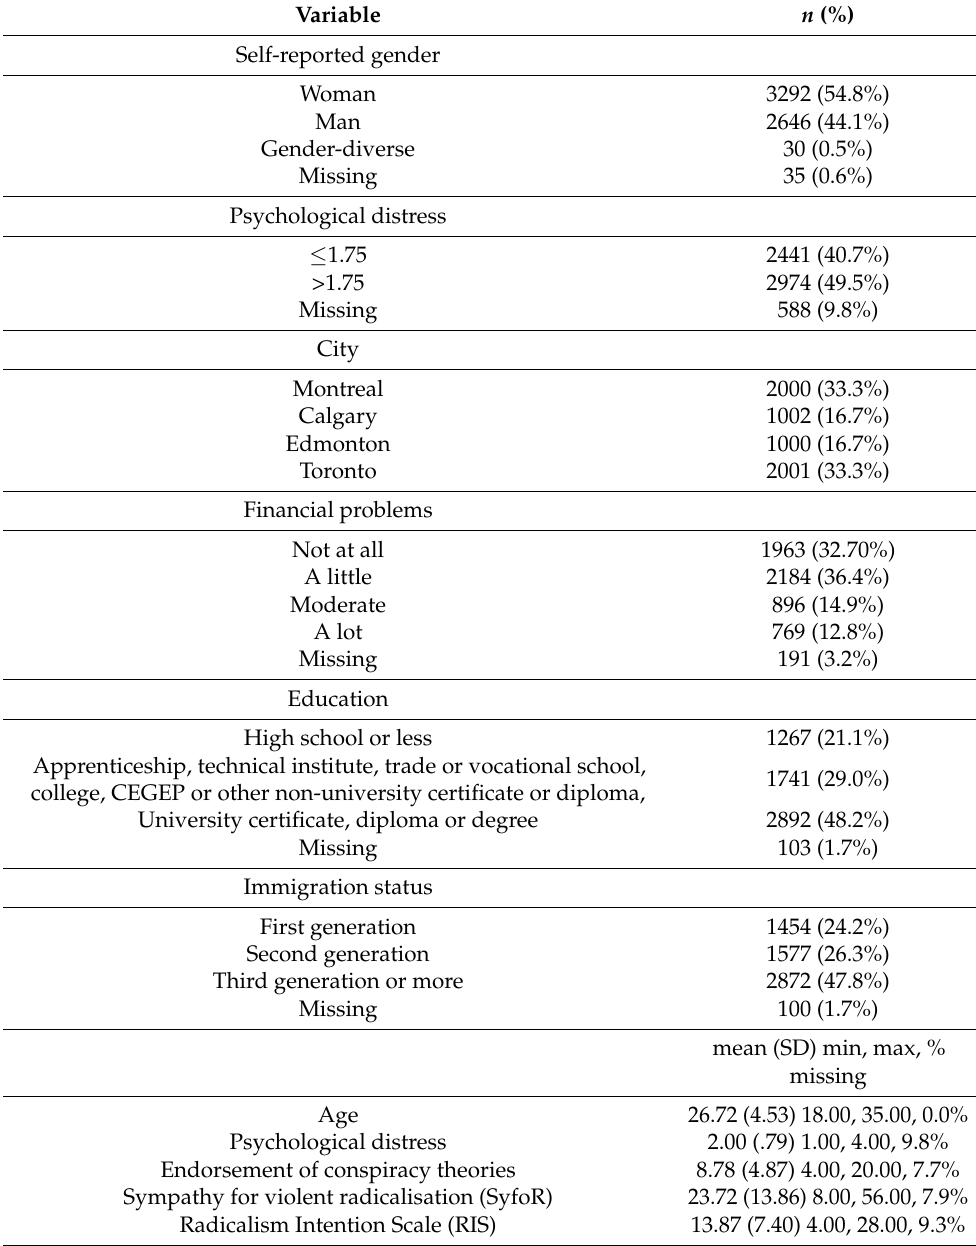
Table 1. Descriptive statistics of